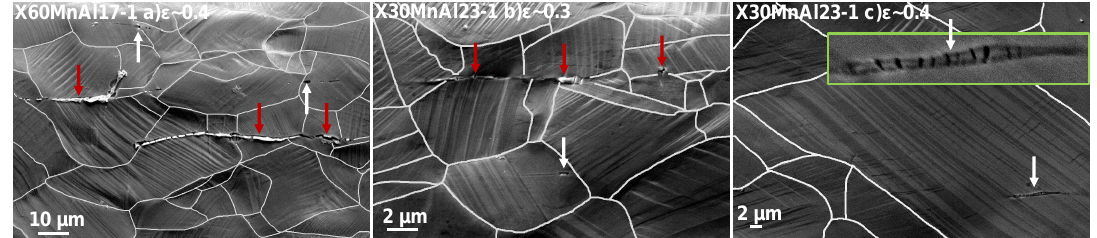
Figure 11. Micro-cracks at inclusions. X60MnAl17-1: ( a ) Micro-cracks in AlN inclusions at GB and in MnS inclusions close to GB and also inside the grains, X30MnAl23-1: ( b ) Micro-cracks in MnS inclusion at GB, ( c ) Micro-cracks in MnS inclusion inside a grain; red arrows indicates cracks in inclusions at GB; white arrows indicate cracks in inclusions inside the grains.